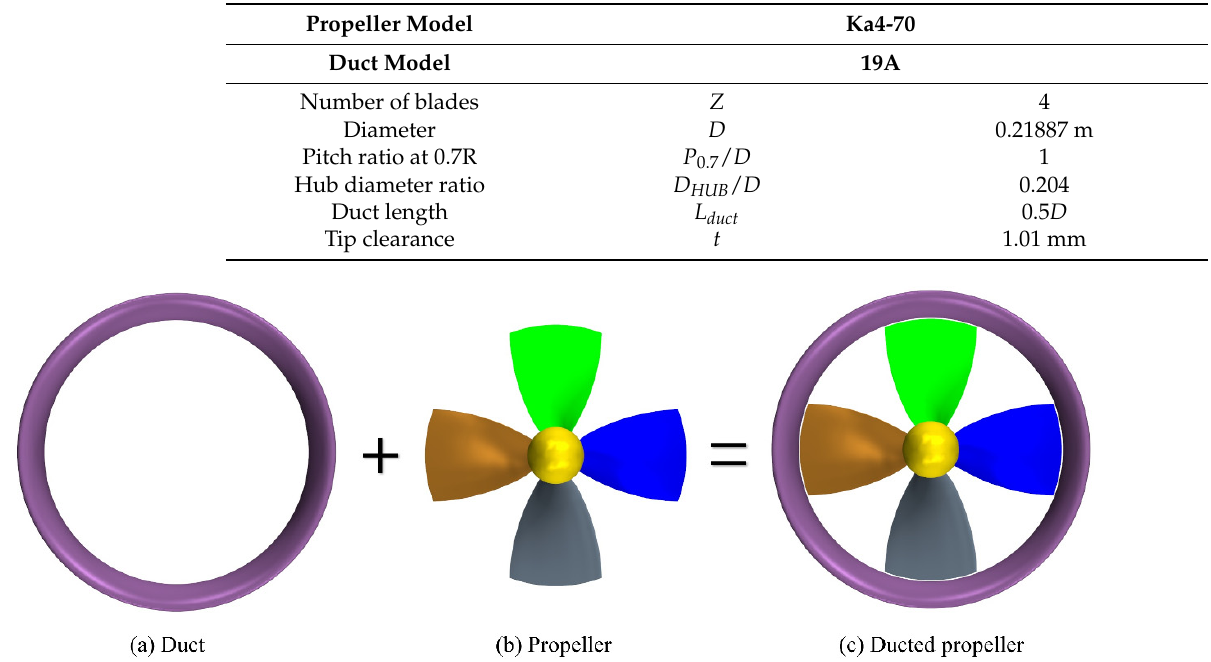
Figure 1. Geometric model of the Ka4-70 propeller in the 19A duct.